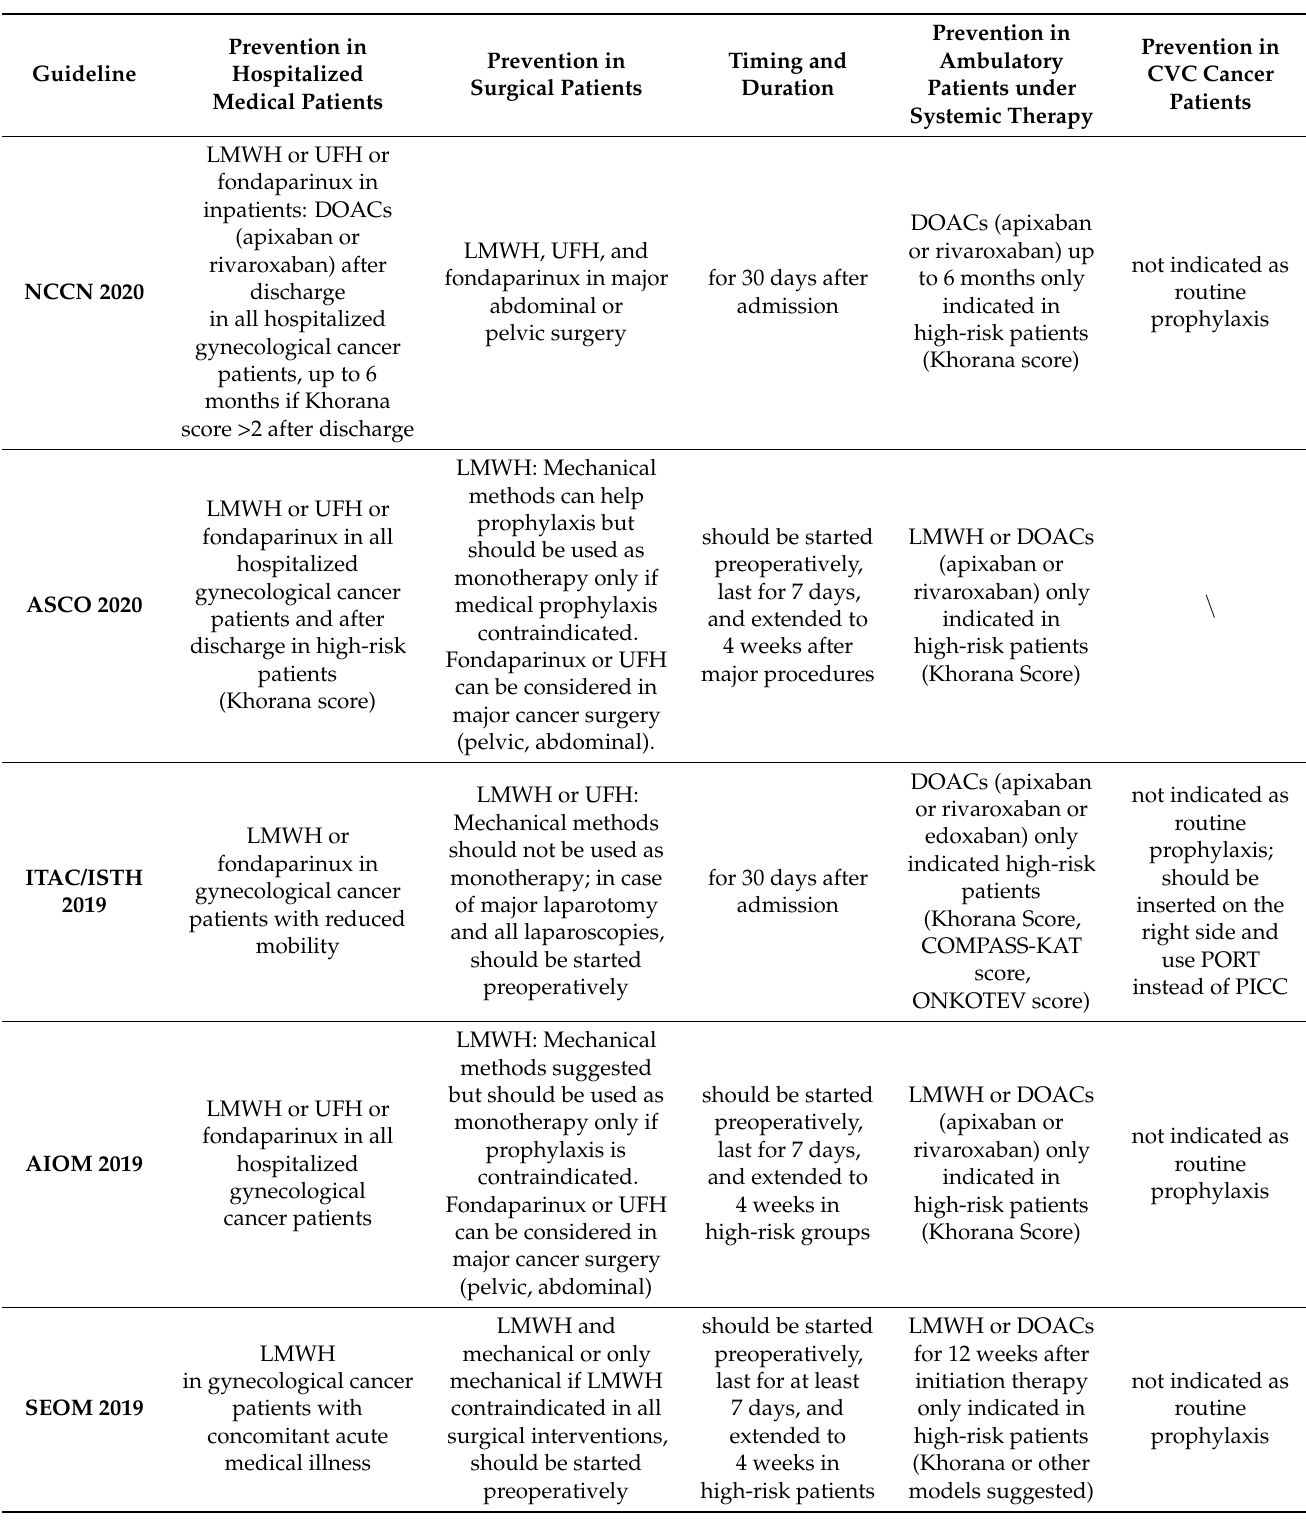
Table 2. VTE prevention in cancer patients: guidelines’